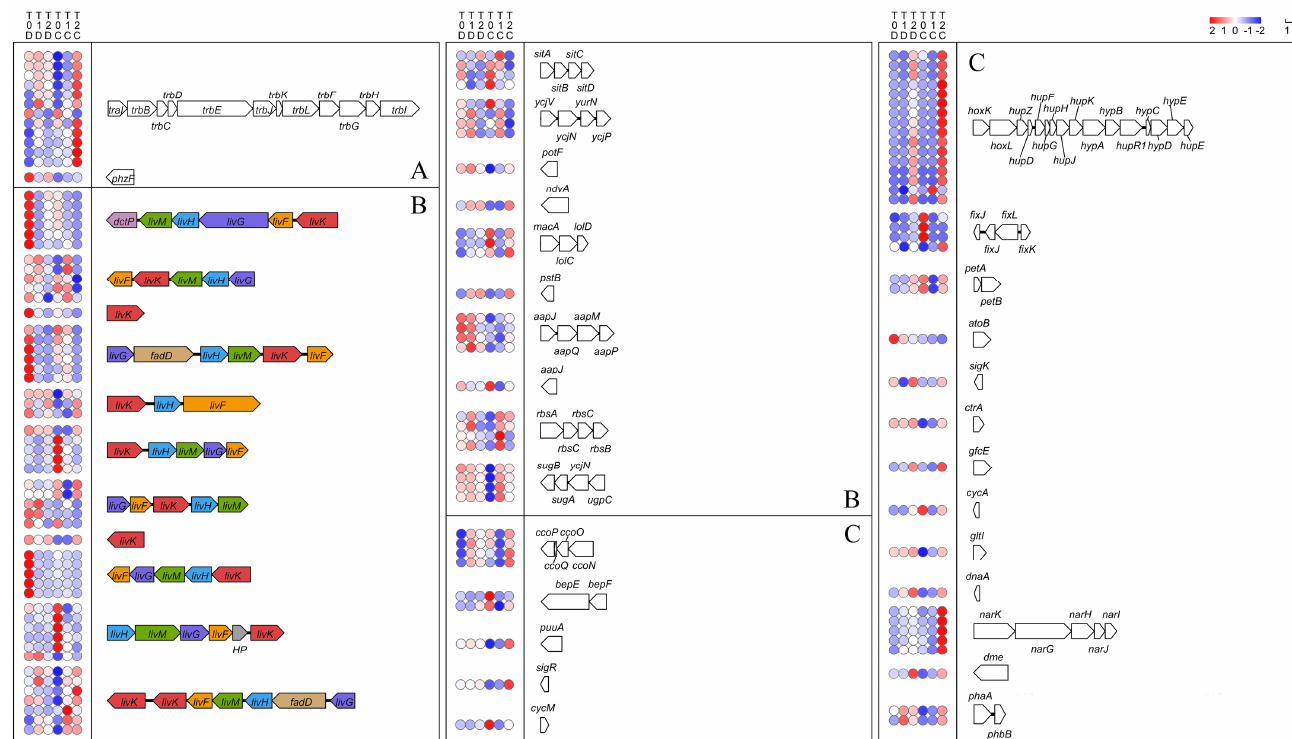
Figure 3. Heatmap and schemes of DEGs related to ( A ) quorum sensing, ( B ) ABC transport system, and ( C ) two-component system involved in dioxane degradation. Circles represent heatmap of gene expression, with genes ordered vertically. HP is the abbreviation for hypothetical